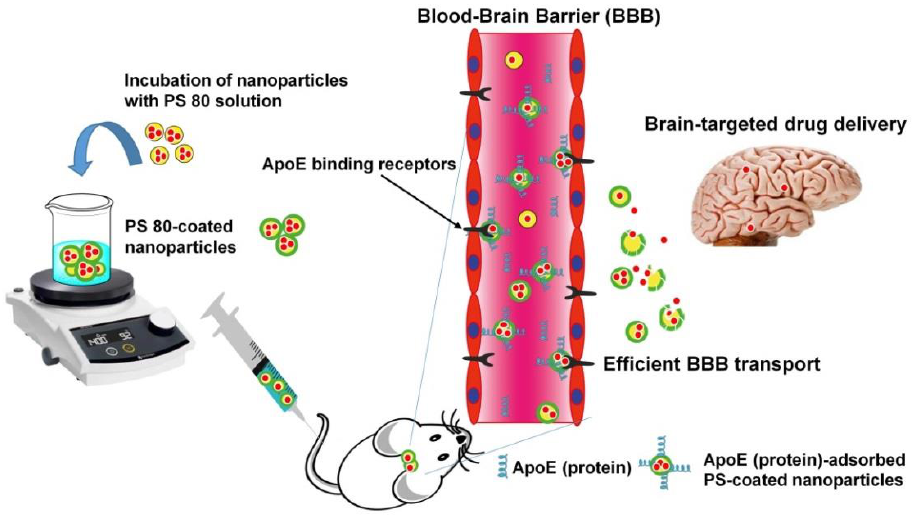
Figure 7. Schematic representation of PS 80-mediated drug delivery to brain. PS 80 enables the adsorption of ApoE onto NPs, and the PS 80-coated NPs interact with lipoprotein receptors on the